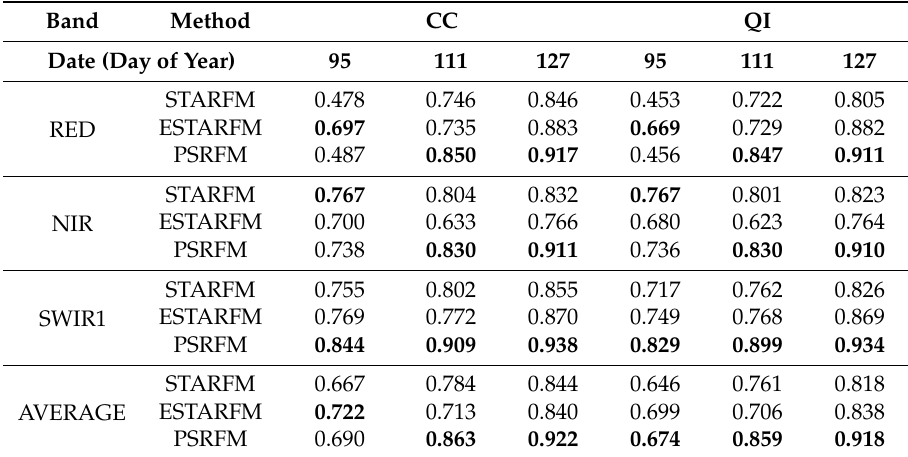
Table 3. Quality indices CC and QI of the predicted Landsat-like image time series by the three models STARFM, ESTARFM and